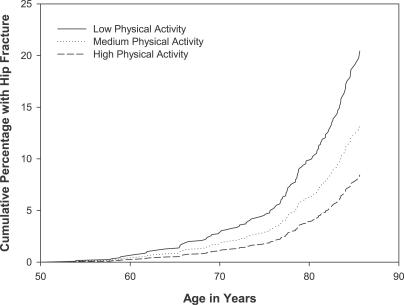
Survival Curves of Hip Fractures after Study Entry at 50 y of Age for the Time-Dependent Low, Medium, and High Physical CategoriesSurvival curves are adjusted by changes in physical activity during follow-up.